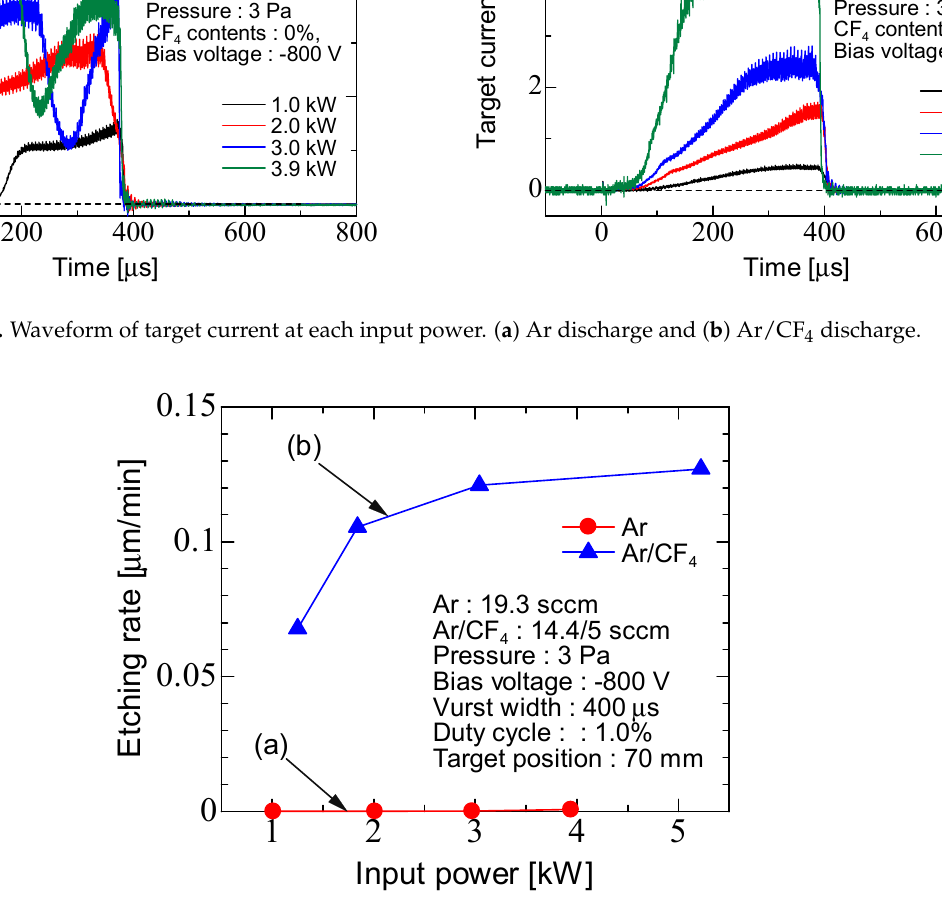
Figure 9. Input power characteristics of the etching rate for ( a ) Ar discharge and ( b ) Ar/CF 4 dis- charge.